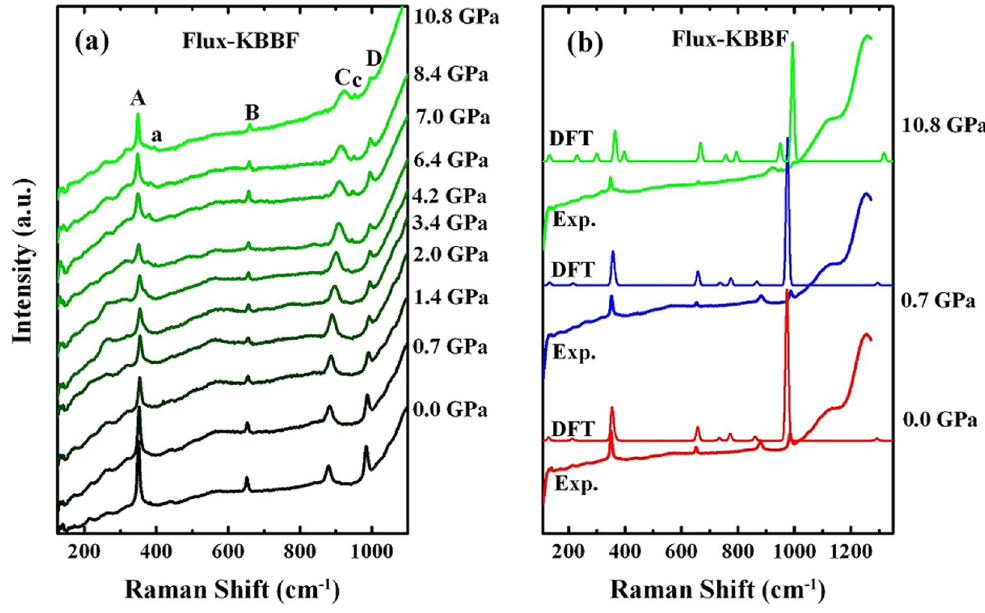
Figure 7. Raman spectra as a function of pressure are shown in ( a ) and the comparisons between DFT and experiment results are indicated in ( b ) for flux-KBBF.